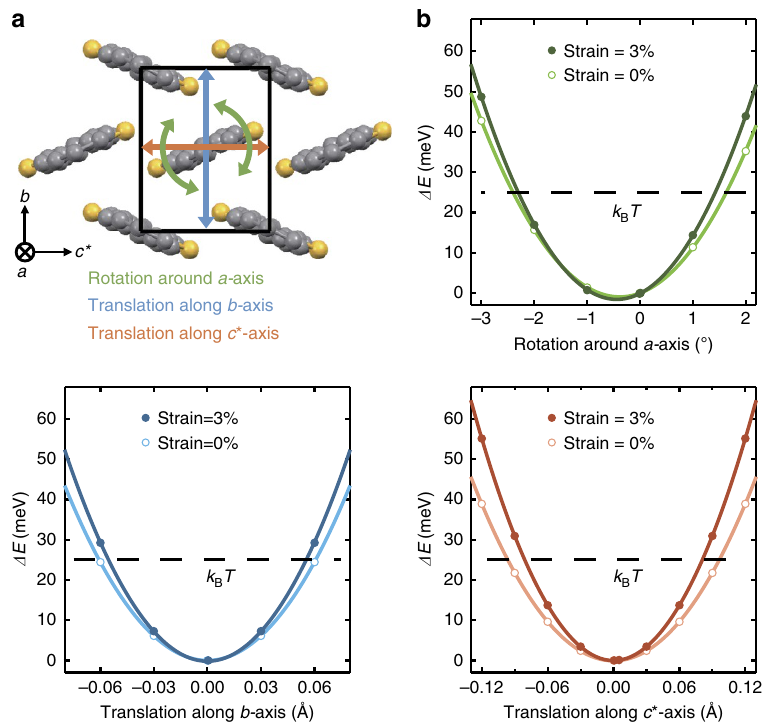
Figure 4 | Suppression of dynamic disorder under uniaxial compressive strain. ( a ) DFTcalculations were used to study the translational and rotational energy of a single molecule in the crystal lattice. ( b ) Under a 3% strain, the amplitude of the harmonic oscillation of the molecule is suppressed by about 8.7–16% (translation along b and c *) and 7.5% (rotation around a ). This is equivalent to a temperature reduction by 50–85K (translation along b and c *) and 45K (rotation around a